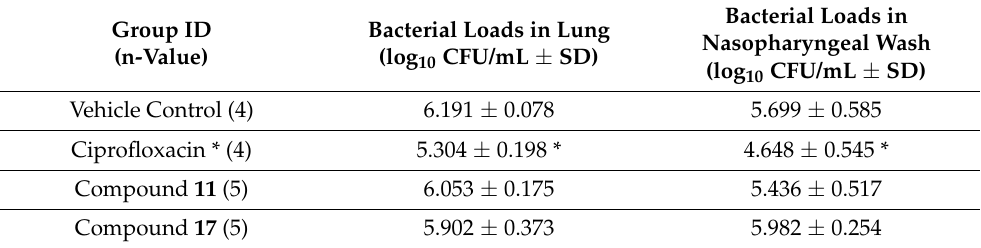
Table 3. Comparison of bacterial loads in lungs and nasopharyngeal washes after treatment with a commercially available antibiotic and compounds 11 and 17